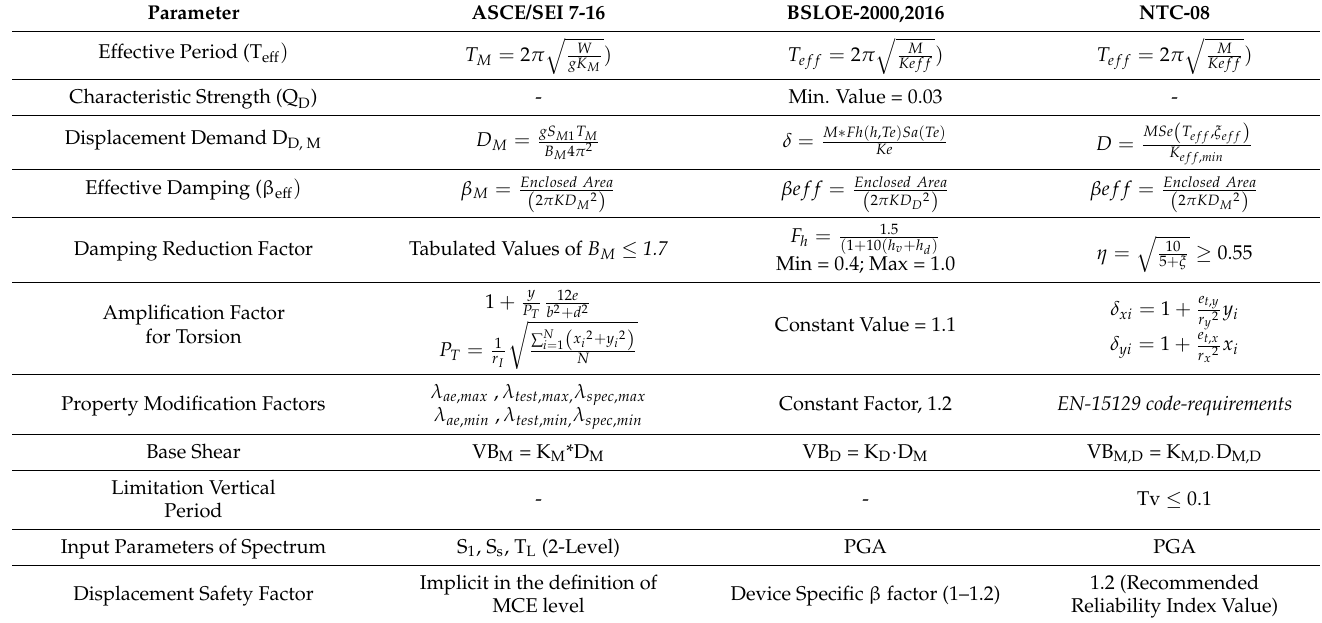
Table 2. Parameters that are used in ELF procedure in design provisions